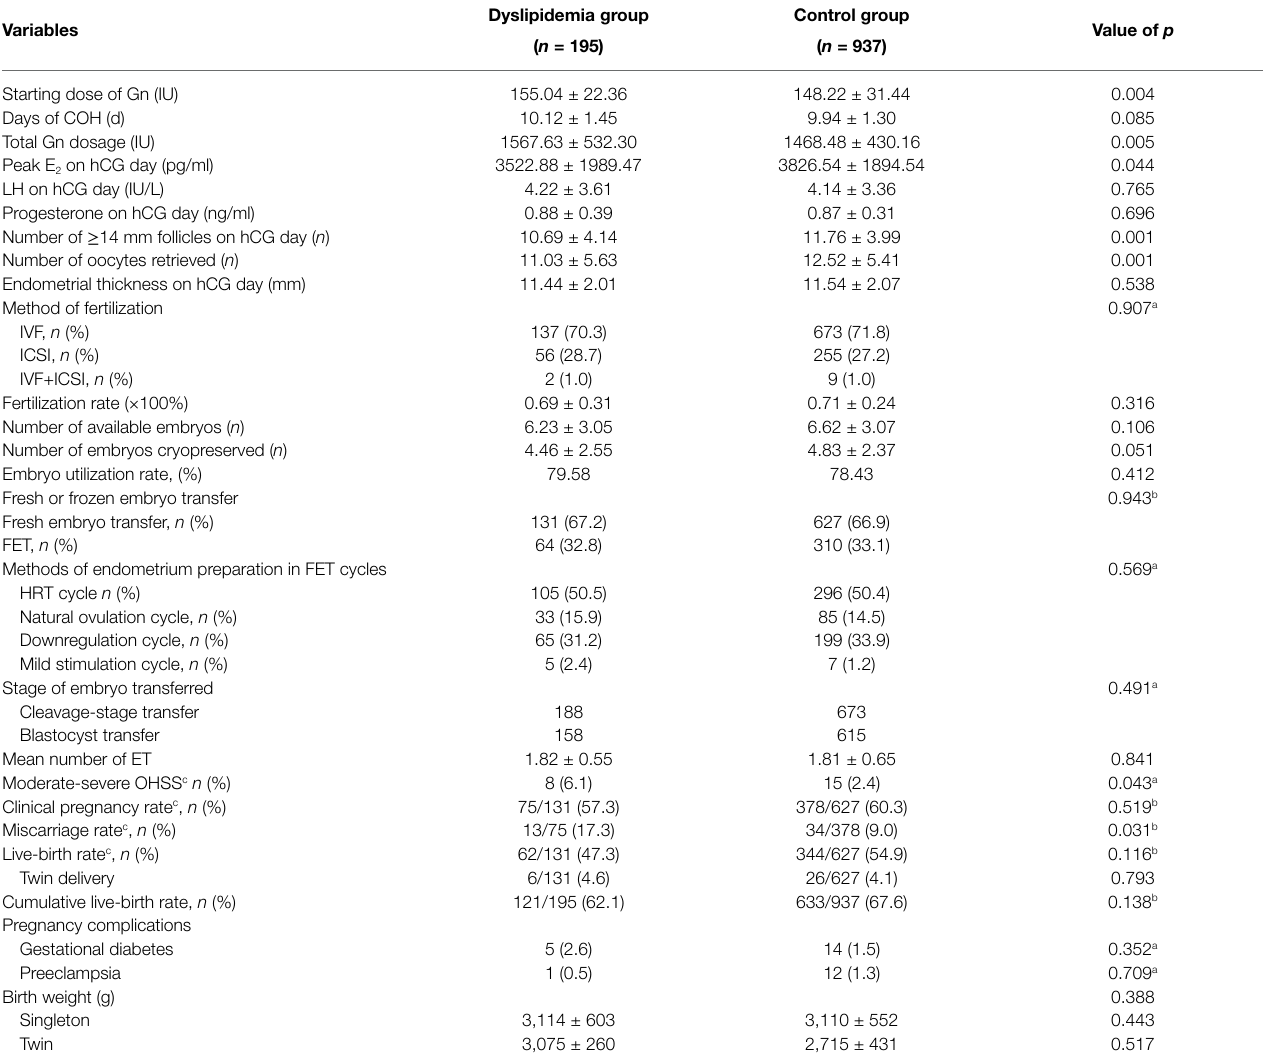
TABLE 2 | COH parameters and pregnancy outcomes in non-PCOS patients with and without dyslipidemia.